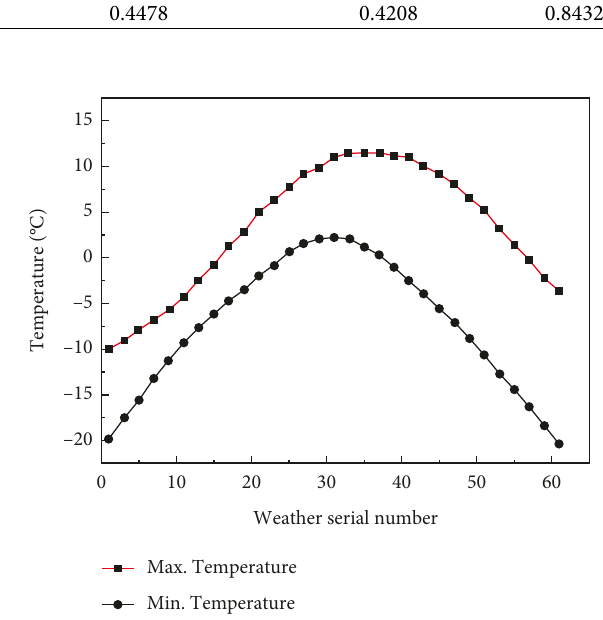
Figure 7: SVM predicts the daily maximum and minimum